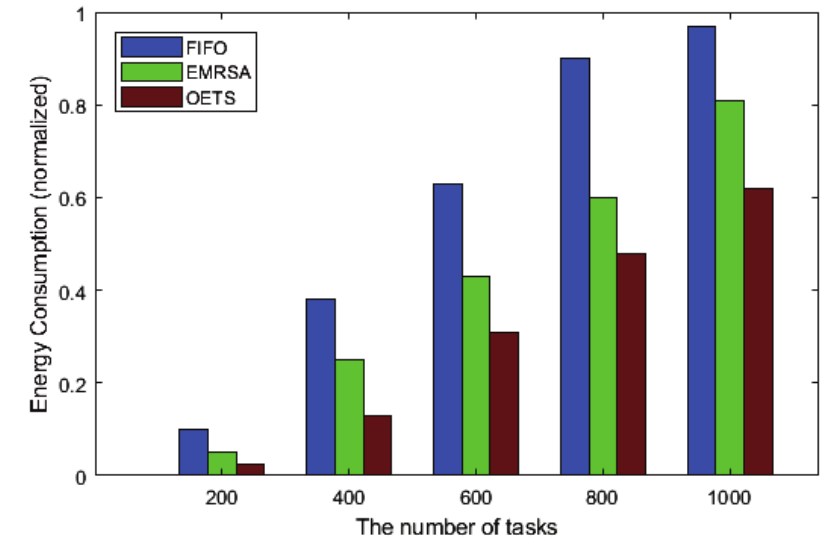
Figure 4. Energy consumption results.